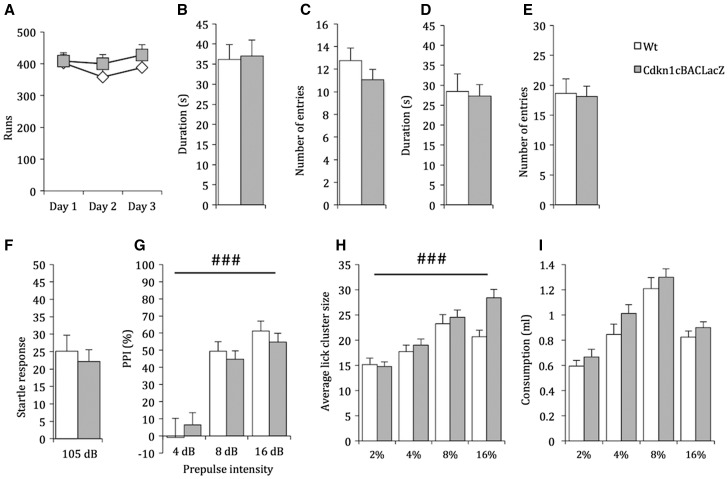
Behavioural alterations in Cdkn1cBACx1 animals were absent when Cdkn1c expression was not elevated. (A) There was no difference between Cdkn1cBACLacZ animals and their WT littermates in LMA. (B–E) Duration of time spent in and number of entries into an anxiogenic zone was not affected by genotype in an (B,C) EPM or (D,E) OF. (F,G) ASR and PPI was not different between Cdkn1cBACLacZ animals and WT littermates. Average lick cluster size (H) was equivalent between groups, as was consumption (I) of a palatable sucrose solution. Data shown is ± SEM. Main effects of within subject factors (PPI, Concentration) ###= P < 0.001.